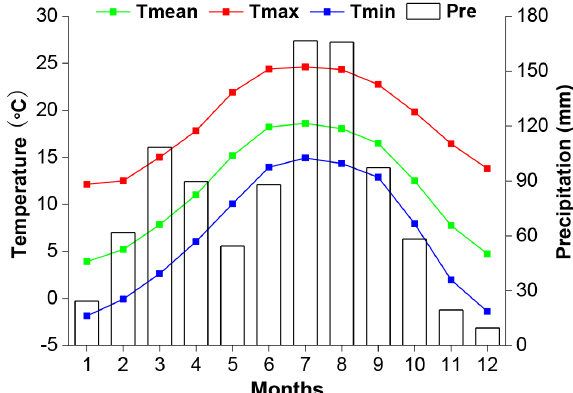
Figure 2. The ombrothermic diagram of the climate variables in the study